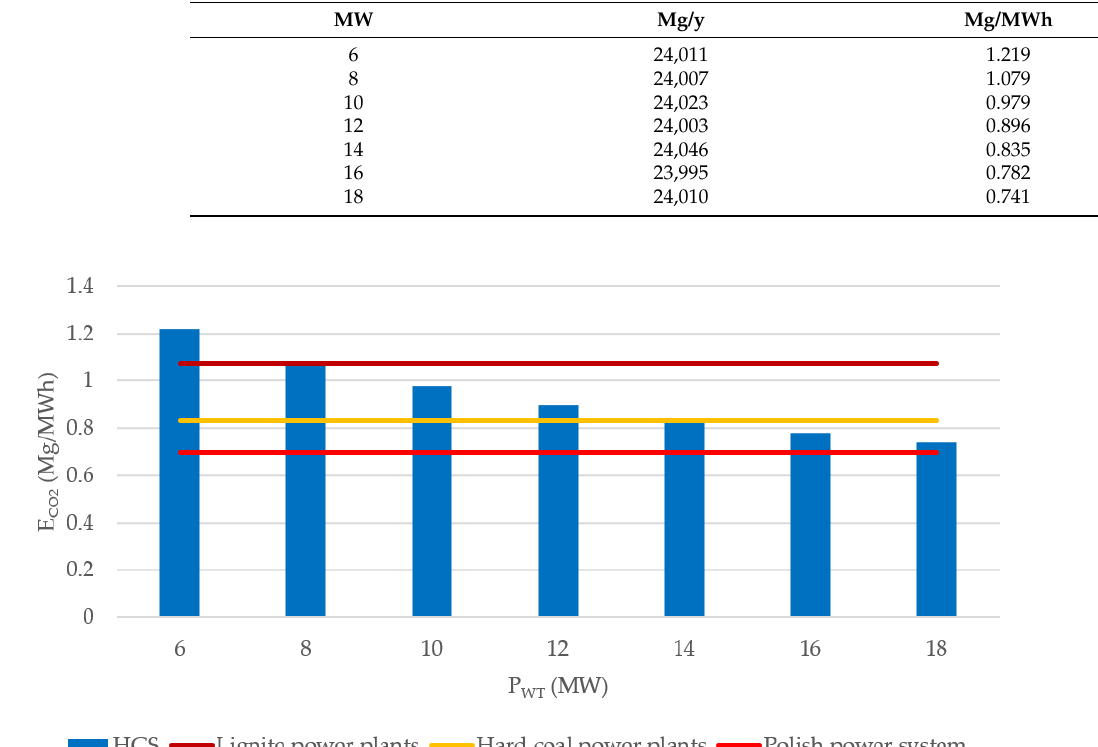
Figure 14. Emission factors of HGS, Polish power system, lignite and hard coal power plants.